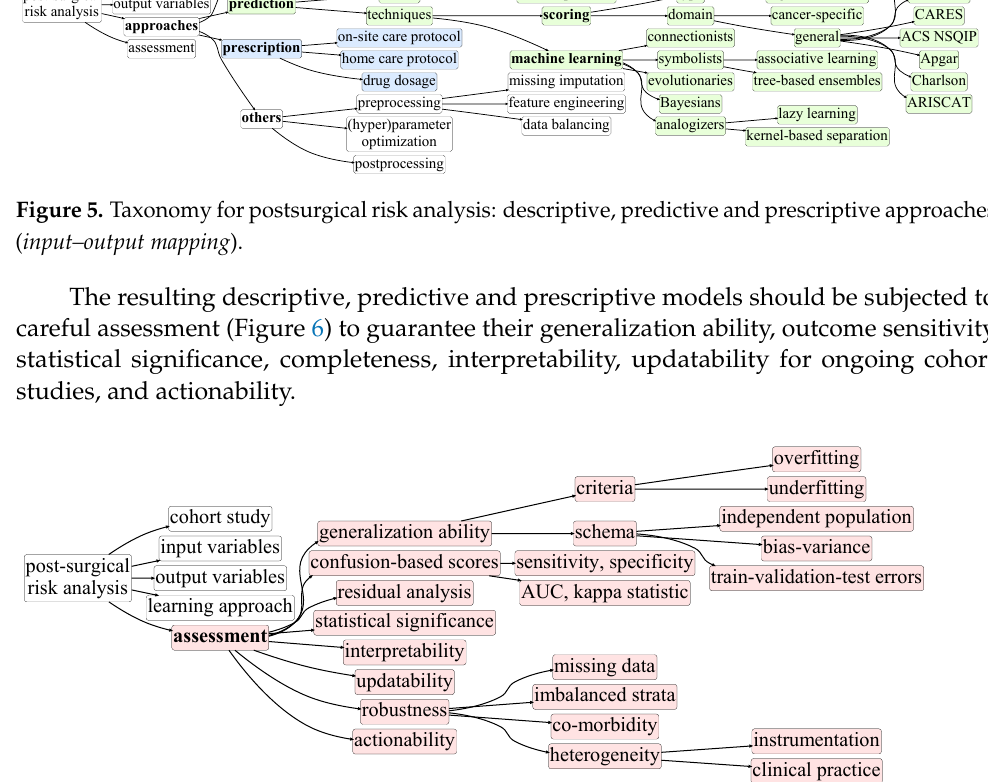
Figure 6. Taxonomy for postsurgical risk analysis: